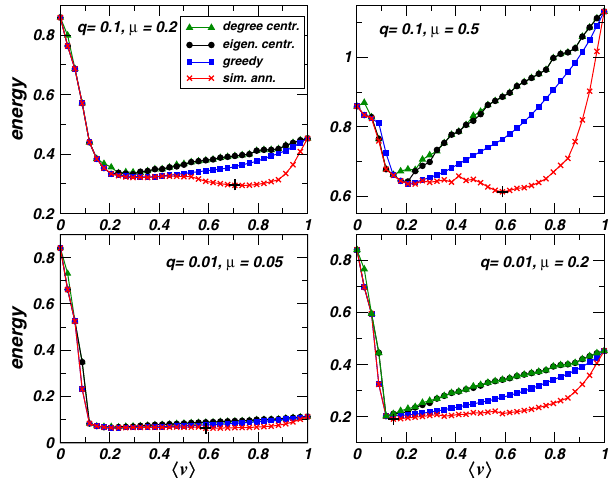
FIG. 16. Energy as a function of h v i for immunization sets obtained using degree (green triangles) and eigenvector centrality (black circles), the greedy algorithm (blue squares), and fixed- density simulated annealing (red crosses), for the SIR model ( p ¼ 0 . 5 ) on Zachary ’ s karate club network of N ¼ 34 individ- uals. The MS results are indicated by black vertical crosses. The immunization cost was assumed to be half of the degree of a